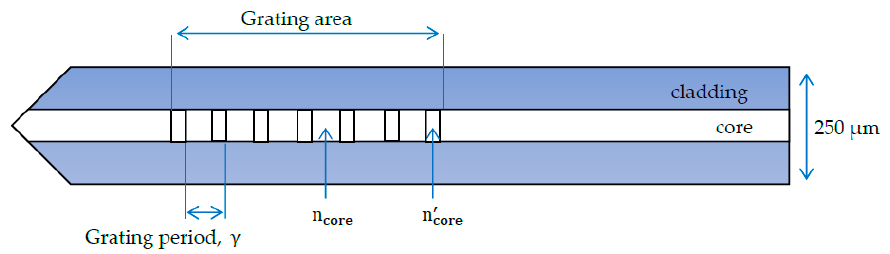
Figure 7. A schematic illustration showing the effect of the refractive index after engraving a fibre Bragg grating onto an optical fibre.